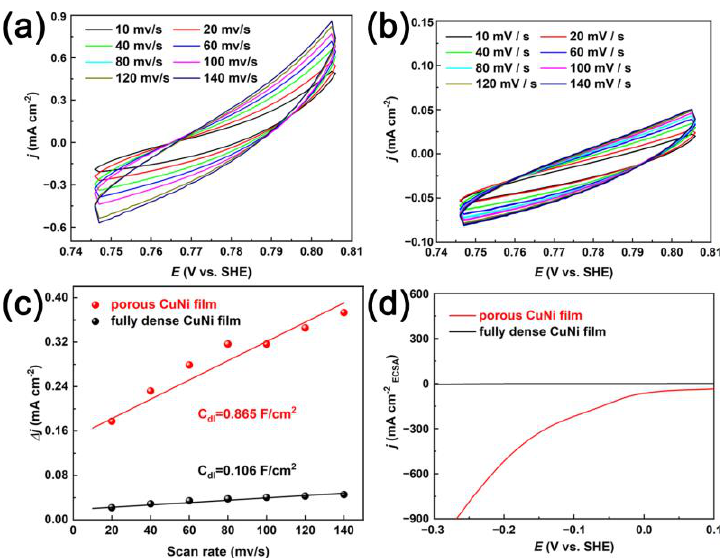
Figure 8. CVs of porous ( a ) and fully dense ( b ) CuNi films at various scan rates (10 – 140 mV/s) in the potential region of 0.747 – 0.805 V vs. SHE. ( c ) Capacitive current densities at 0.776 V (vs. SHE) as a function of scan rate for porous and fully dense CuNi films. ( d ) Polarization curves of the two CuNi films calculated by ECSA.